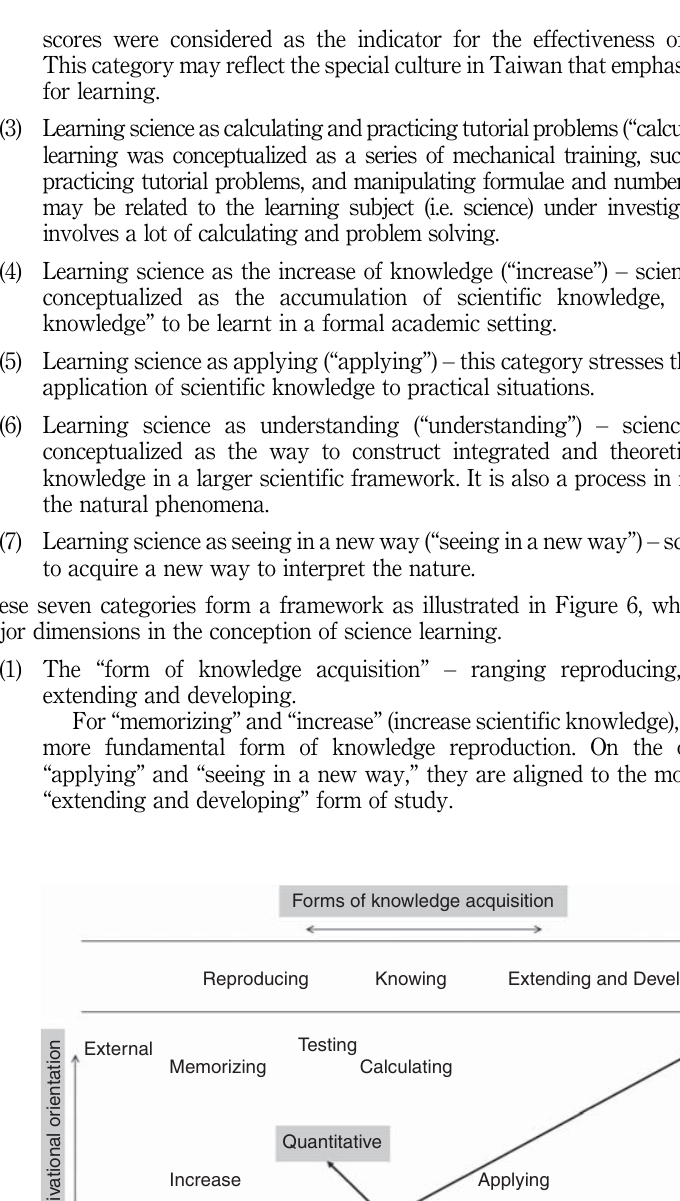
Figure 6. A framework which describes students ’ conceptions of science